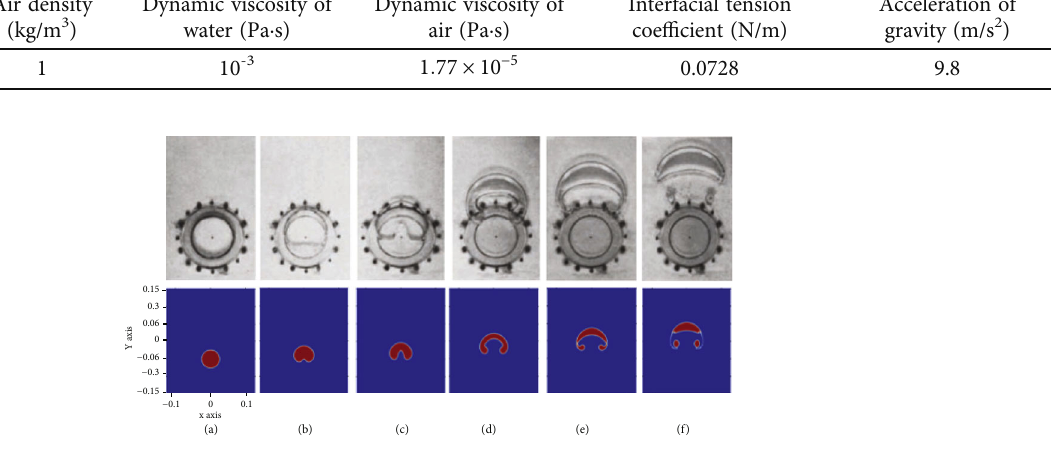
Figure 9: shows the change of bubble shape at di ff erent times: (a) t = 0 : 0107 s, (b) t = 0 : 0574 s, (c) t = 0 : 0898 s, (d) t = 0 : 1724 s, (e) t = 0 : 2125 s, and (f) t = 0 : 2625 s.